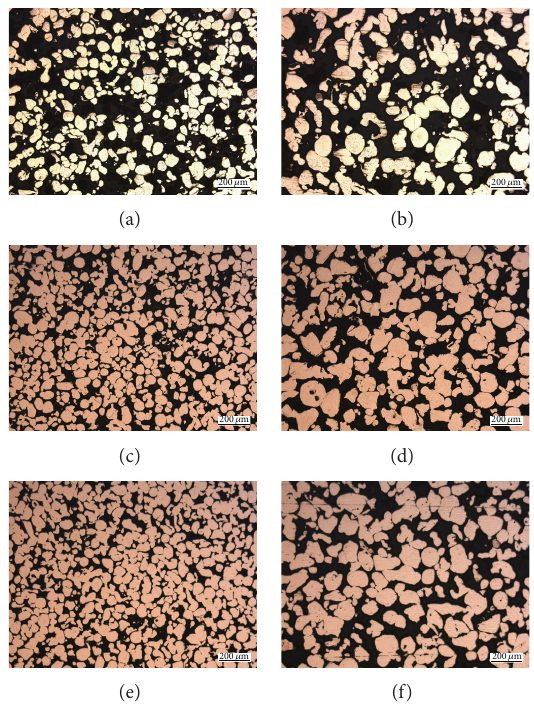
Figure 2: Microscopic pictures of the sintered structures from copper powders. (a) Grain size of 50 𝜇 m, sintering temperature of 800 ∘ C, and sintering time of 30 min. (b) Grain size of 100 𝜇 m, sintering temperature of 800 ∘ C, and sintering time of 30 min. (c) Grain size of 50 𝜇 m, sintering temperature of 950 ∘ C, and sintering time of 30 min. (d) Grain size of 100 𝜇 m, sintering temperature of 950 ∘ C, and sintering time of 30 min. (e) Grain size of 50 𝜇 m, sintering temperature of 950 ∘ C, and sintering time of 90 min. (f) Grain size of 100 𝜇 m, sintering temperature of 950 ∘ C, and sintering time of 90min.